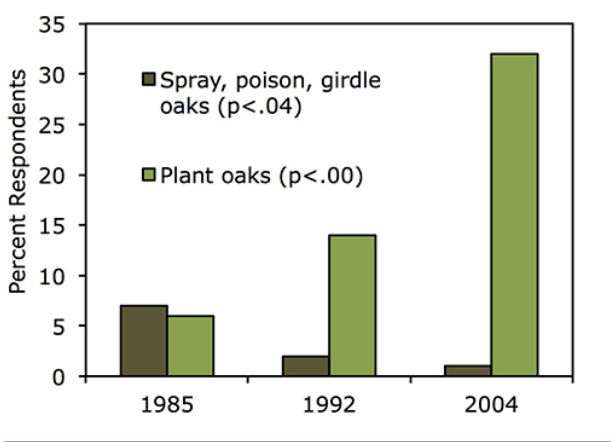
Fig. 4 . Survey of California oak woodland landowners repeated three times from 1985–2004. Note: Landowners and managers reduced oak cutting and increased oak planting. Over the same time period, a statewide outreach and education program emphasized the values of retaining oaks rather than cutting them to increase forage production (Huntsinger et al. 2010 b